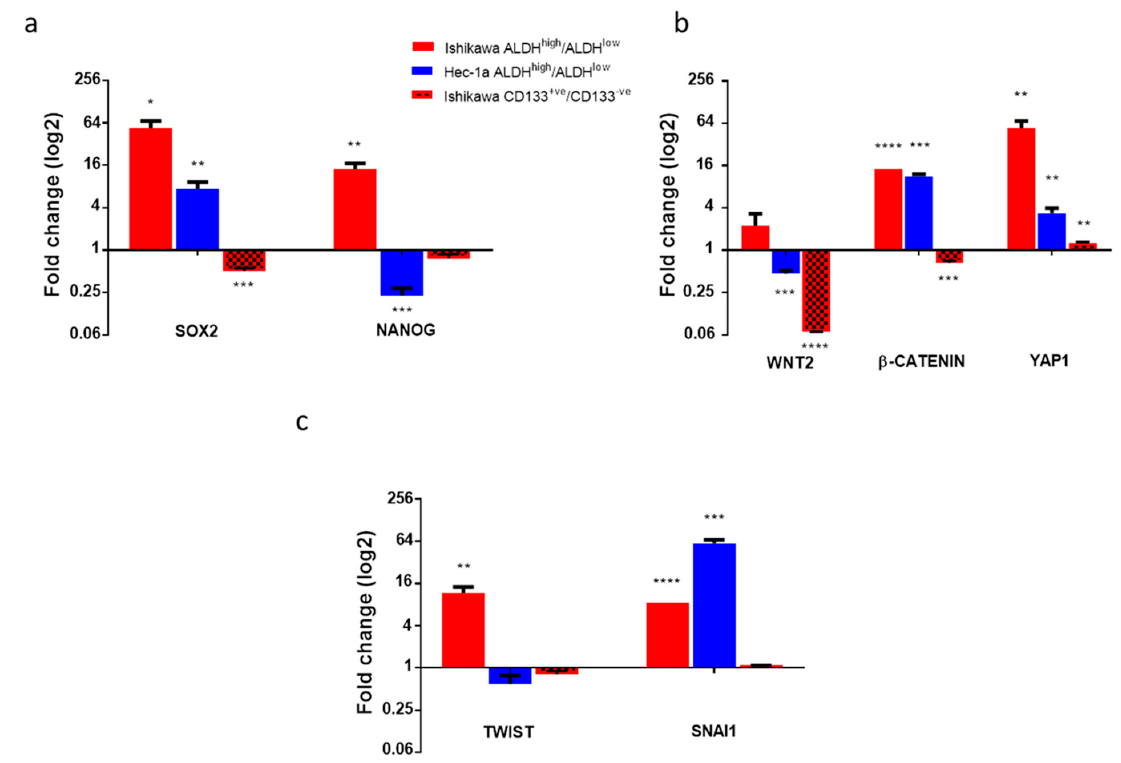
Figure 2. Expression of genes associated with a cancer stem cell phenotype in ALDH high and CD133 +ve endometrial cancer cells. ( a ) qRT-PCR of genes associated with pluripotency (cells capable of giving rise to a number of different cell types) and self-renewal in ALDH high Ishikawa and Hec-1a cells and CD133 +ve Ishikawa cells compared with ALDH low and CD133 -ve cells, respectively ( n = 3). ( b ) qRT-PCR of genes within the Wnt and Hippo signalling pathways in ALDH high and CD133 +ve cells ( n = 3). ( c ) qRT-PCR of epithelial-mesenchymal transition (EMT) transcription factors in ALDH high and CD133 +ve cells ( n = 3). Data are represented as mean ±SEM. * p ≤ 0.05, ** p ≤ 0.01, *** p ≤ 0.001, **** p ≤ 0.0001.